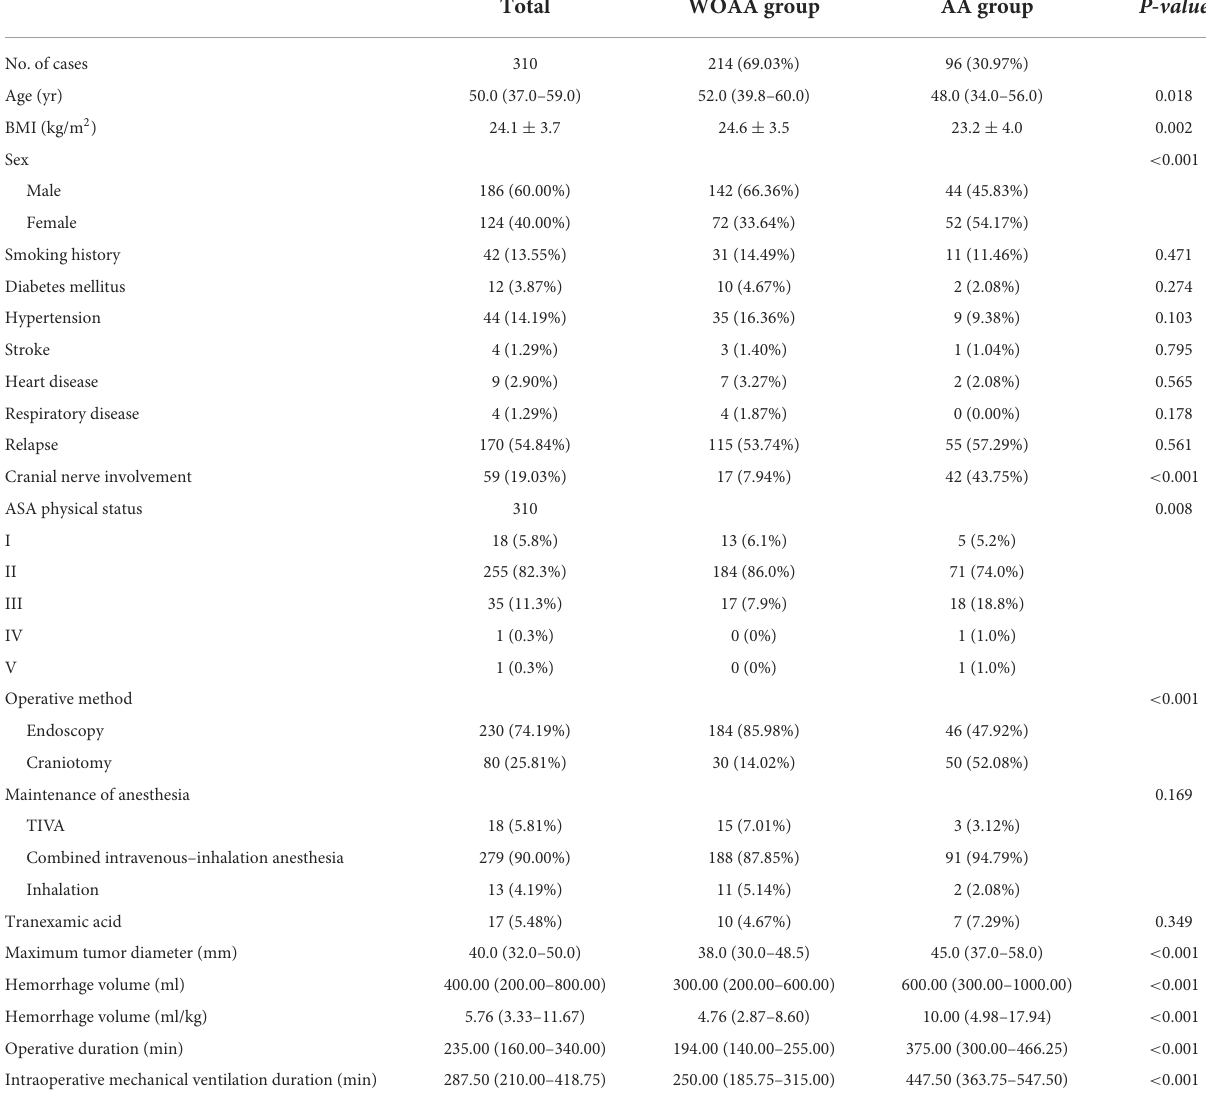
TABLE 1 Patient